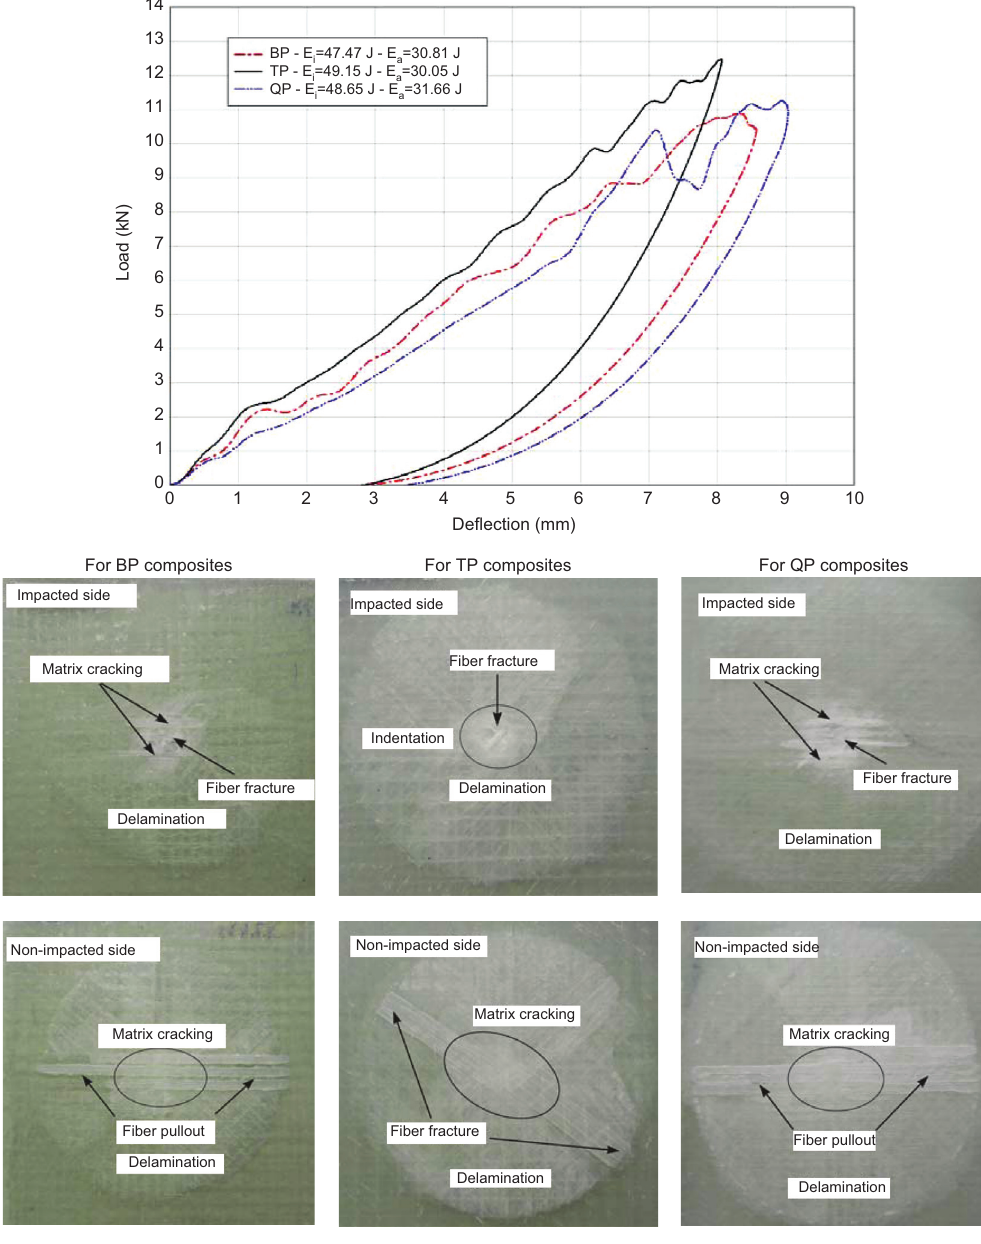
Figure 6 Typical load-deflection (F-d) curves of the BP, TP, and QP composites and images of damaged